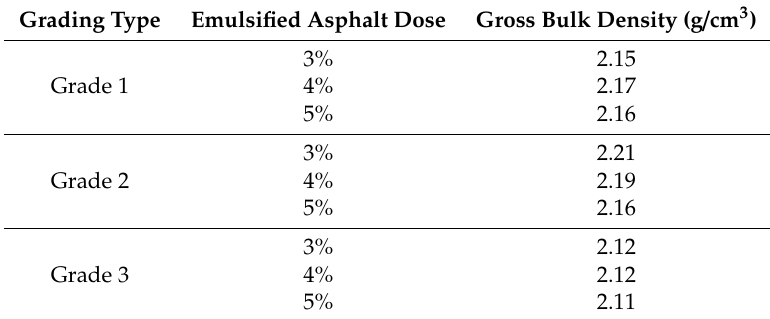
Table 7. Density of different asphalt content for different gradations.